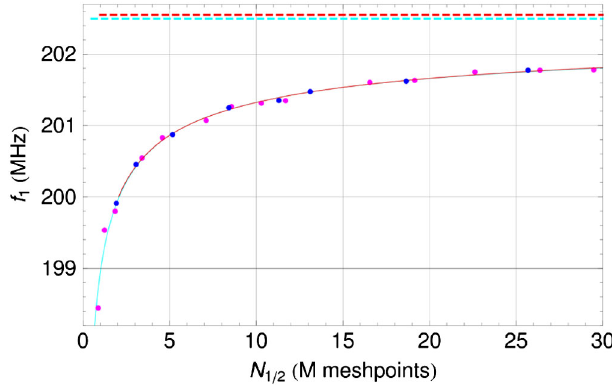
FIG. 24. Fitting the calculated mode frequency of the cold model versus the number of mesh points used in MWS computa- tions. Blue dots are results without adaptive meshes; they are fitted with the red solid curve; the dashed red line shows the correspond- ing asymptotic frequency. Magenta dots are for results with adaptive meshing. They are fitted by the cyan solid curve, and the cyan dashed line indicates the asymptotic